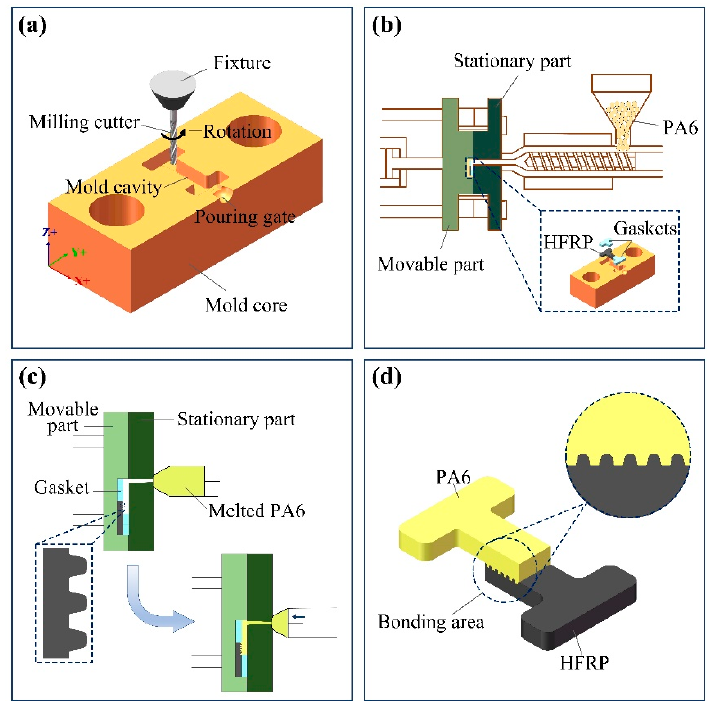
Figure 2. Process flow of the composite part. ( a ) fabrication of the mold core by the 5-axis CNC machining center; ( b ) placement of the HFRP and gaskets; ( c ) injection molding; ( d ) composite part.